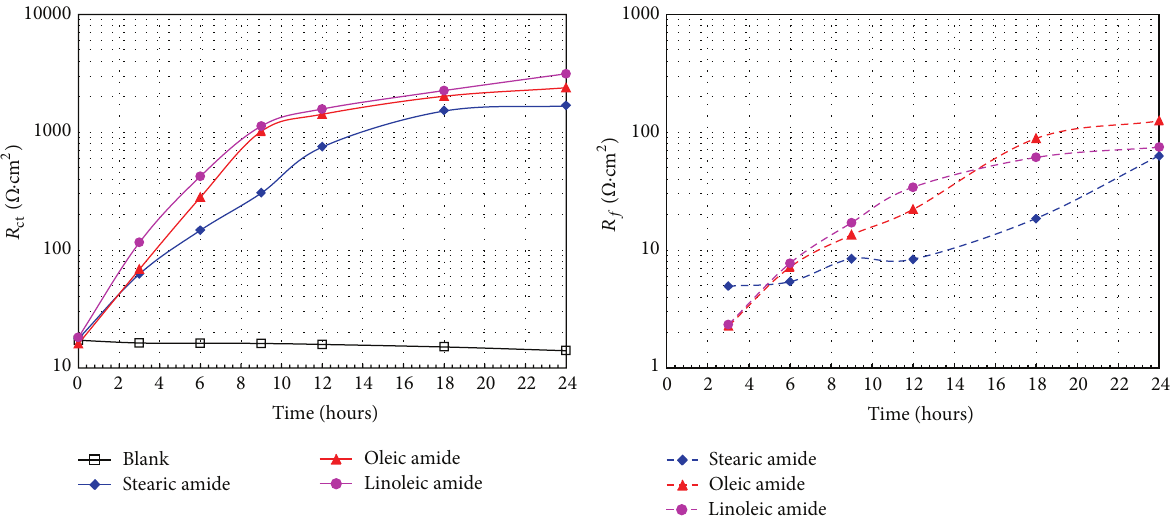
Figure 11: 𝑅 and 𝑅 𝑓 variation against time for carbon steel with and without ct